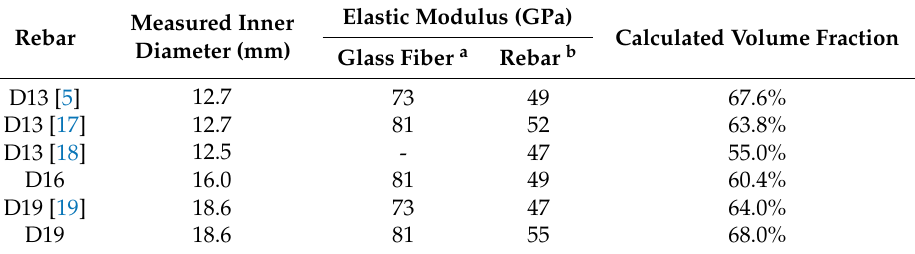
Table 4. Calculation of fiber volume fraction.